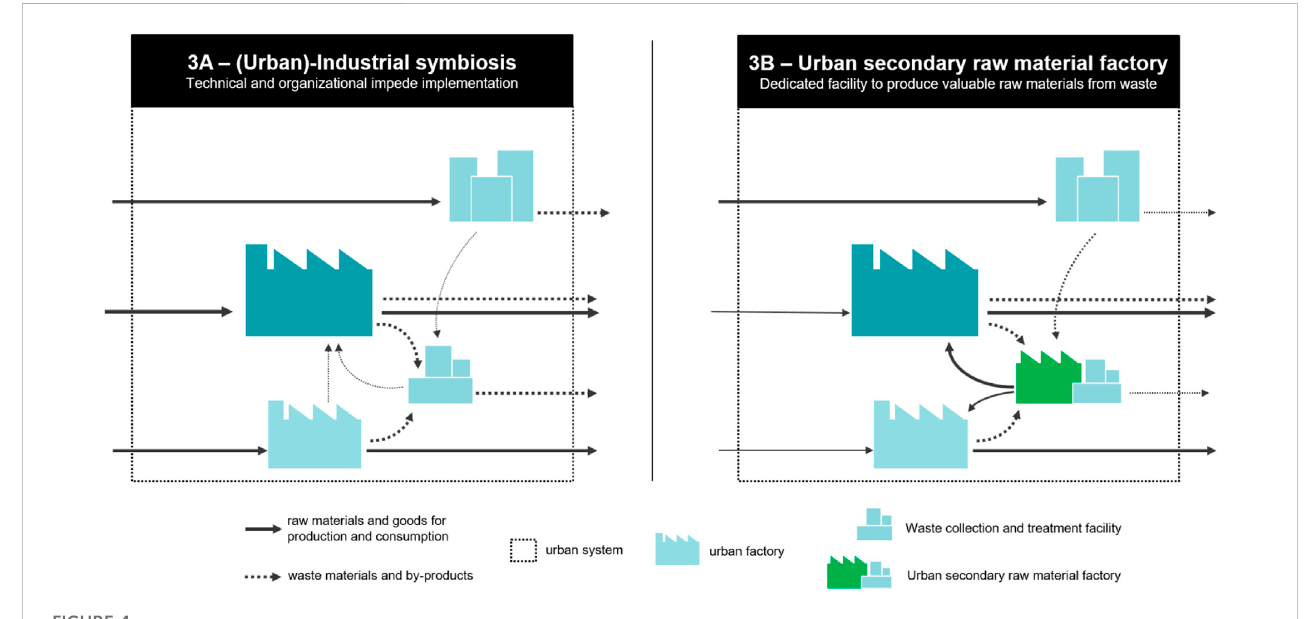
FIGURE 4 The urban secondary raw material factory and its integration in the urban